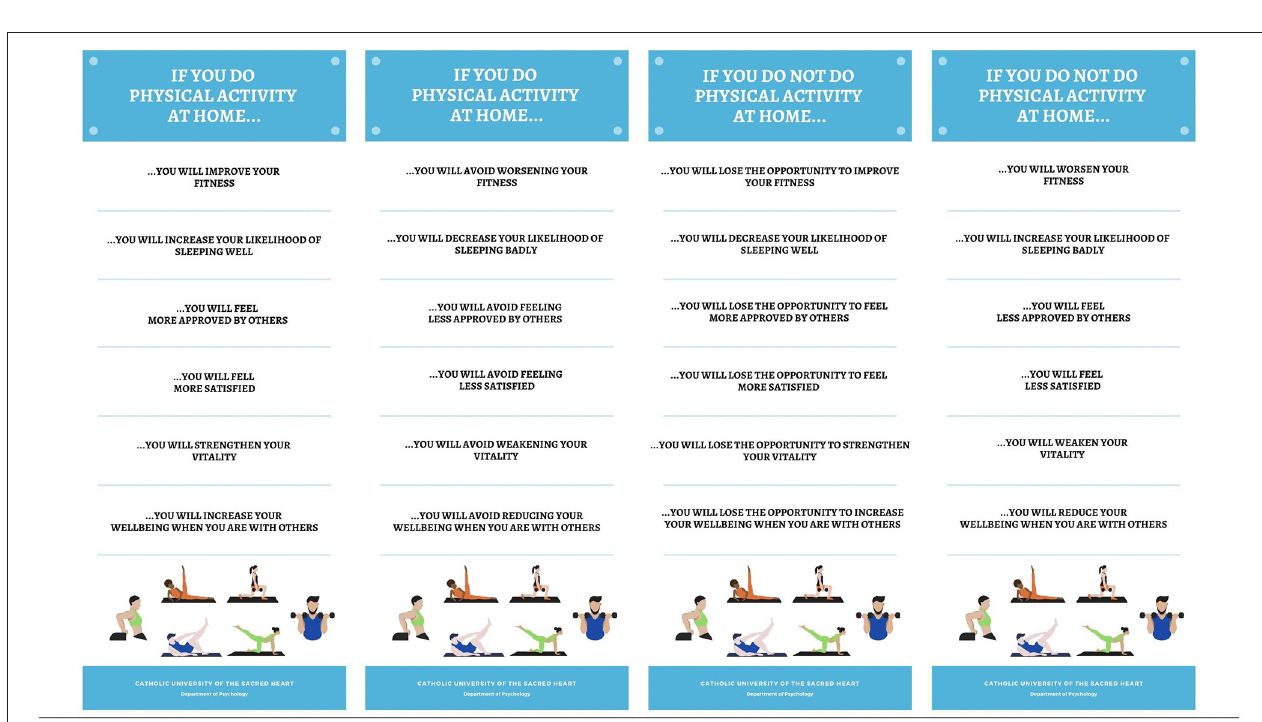
FIGURE 2 | Infographics proposed in the gain, non-loss, non-gain, and loss message conditions.